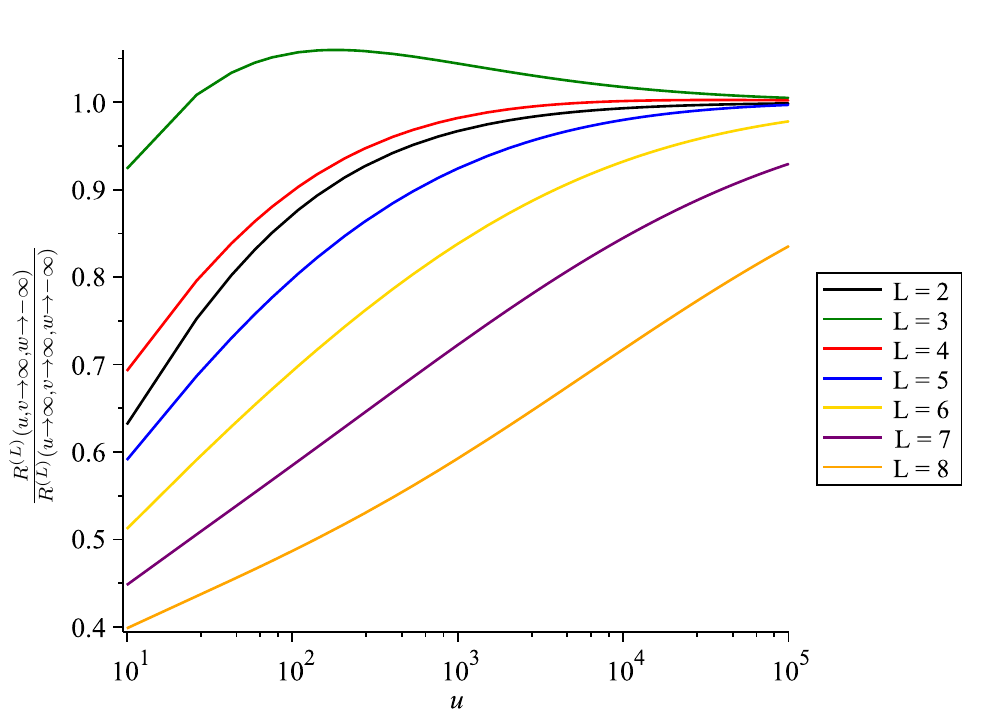
Figure 8. The remainder function R ( L ) in region IIa in the limit v → ∞ at fixed u , from two to eight loops. We have normalized R ( L ) at each loop order by its value at u → ∞